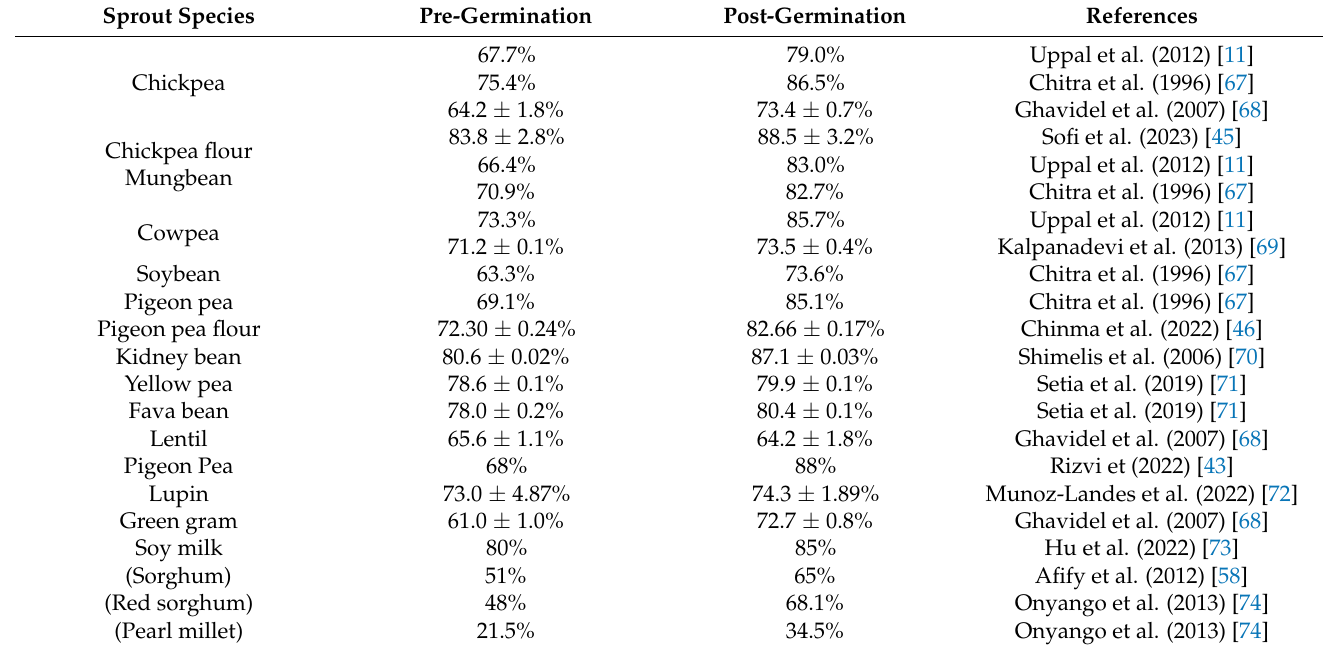
Table 5. Changes in vitro protein digestibility (IVPD) after